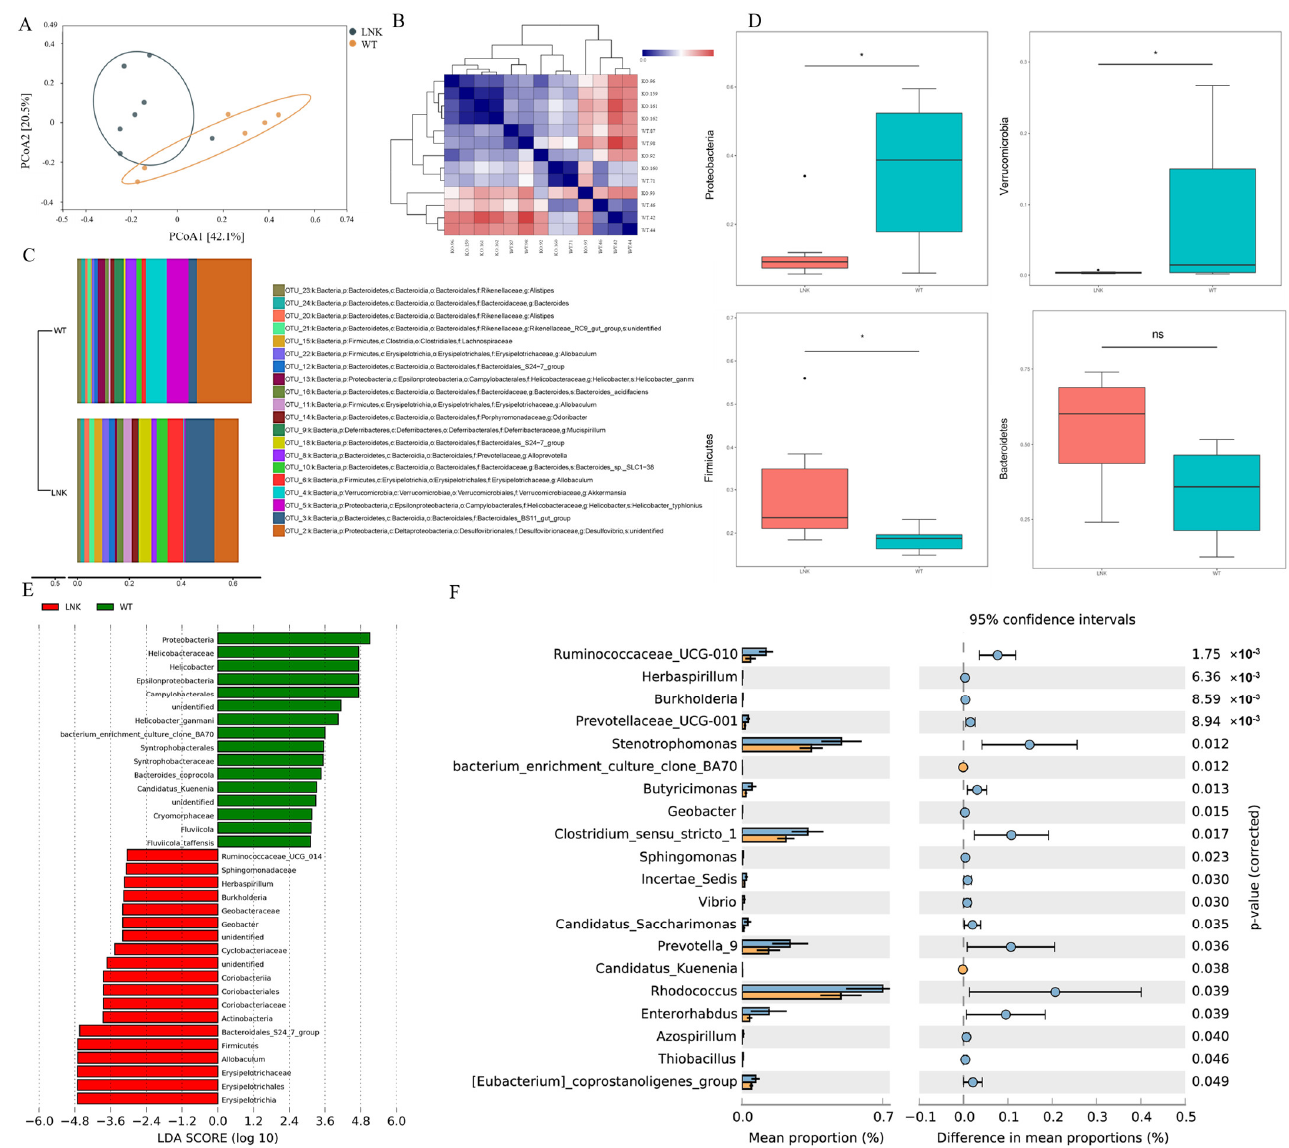
Figure 2. Composition and abundance difference in the intestinal microbiota between LNK-/- and WT mice. ( A ) Principal coordinate analysis (PCoA) of gut microbiota based on Bray–Curtis dissimilarity (Bray–Curtis PERMANOVA, p = 0.016). ( B ) The heat map of gut microbiota compositions between LNK-/- and WT group. ( C ) Taxonomic classification of the gut microbiota of LNK-/- and WT group at the level of phylum. ( D ) Boxplots of Proteobacteria, Verrucomicrobia, Firmicutes, and Bacteroidetes between LNK-/- and WT group (* p < 0.05). ( E ) Linear discriminant analysis of the differential abundance gut microbiota between LNK-/- and WT group. ( F ) Differences in bacterial genera between LNK-/- and WT group ( p < 0.05).